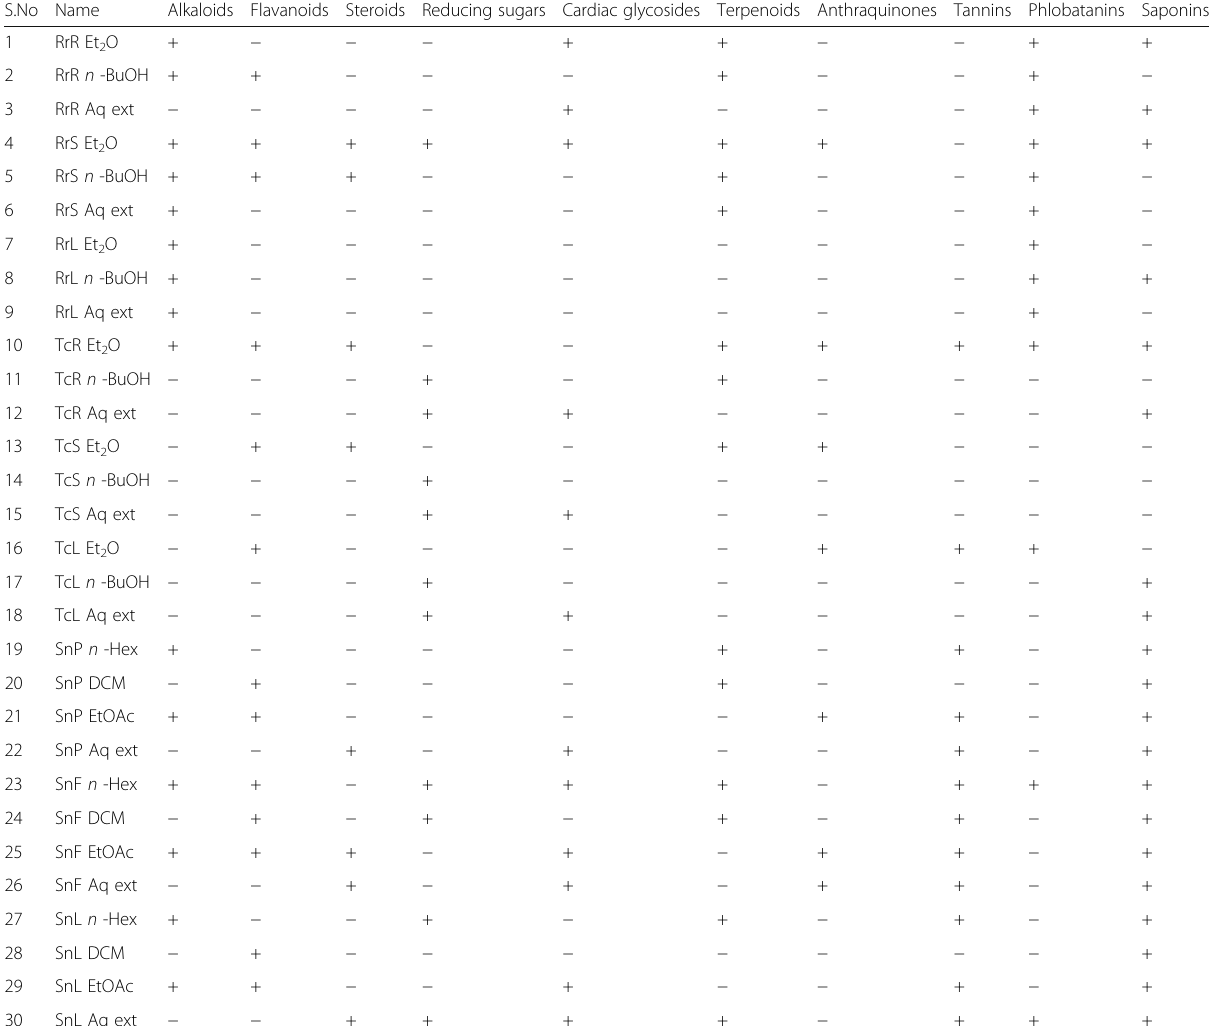
Table 3 Phytochemical screening of crude fractions and extracts of three medicinal orchids of AR